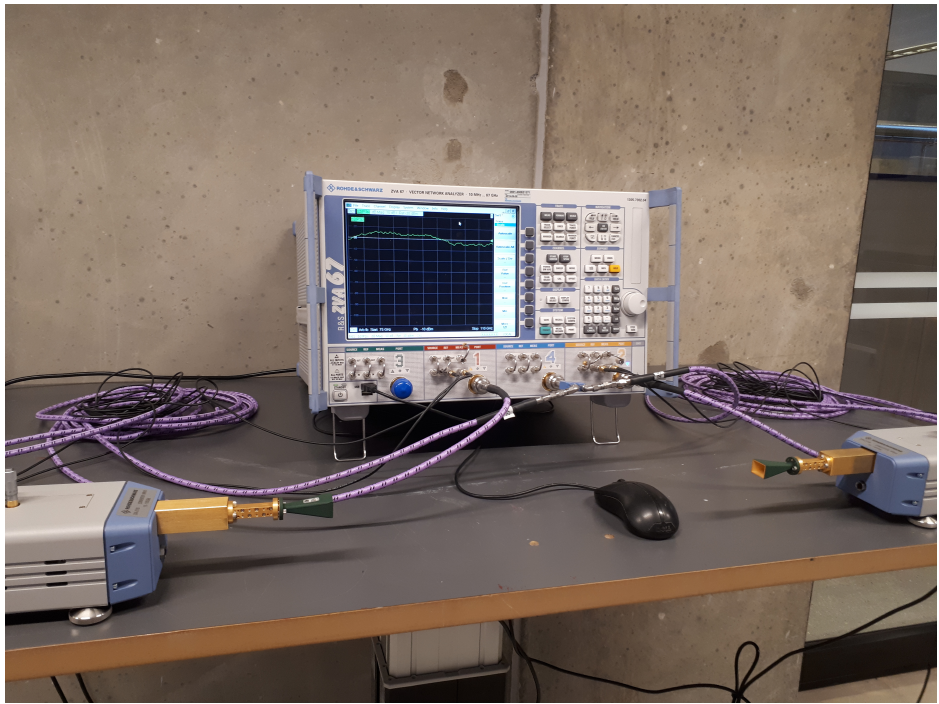
Figure 1. Measurement equipment setup photo to show the cable connection to the VNA and the frequency